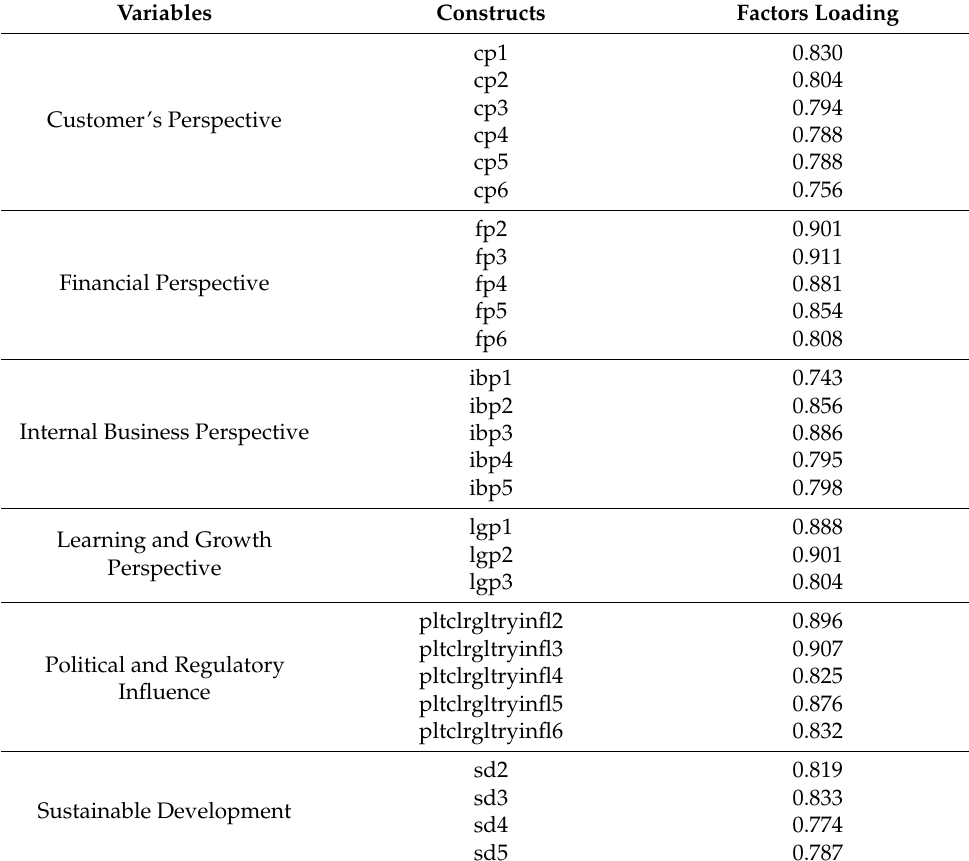
Table 4. Factor loading.